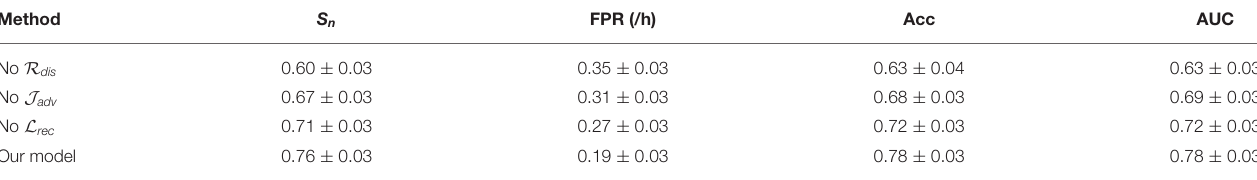
TABLE 7 | Comparison results on the Freiburg Hospital database using various components.